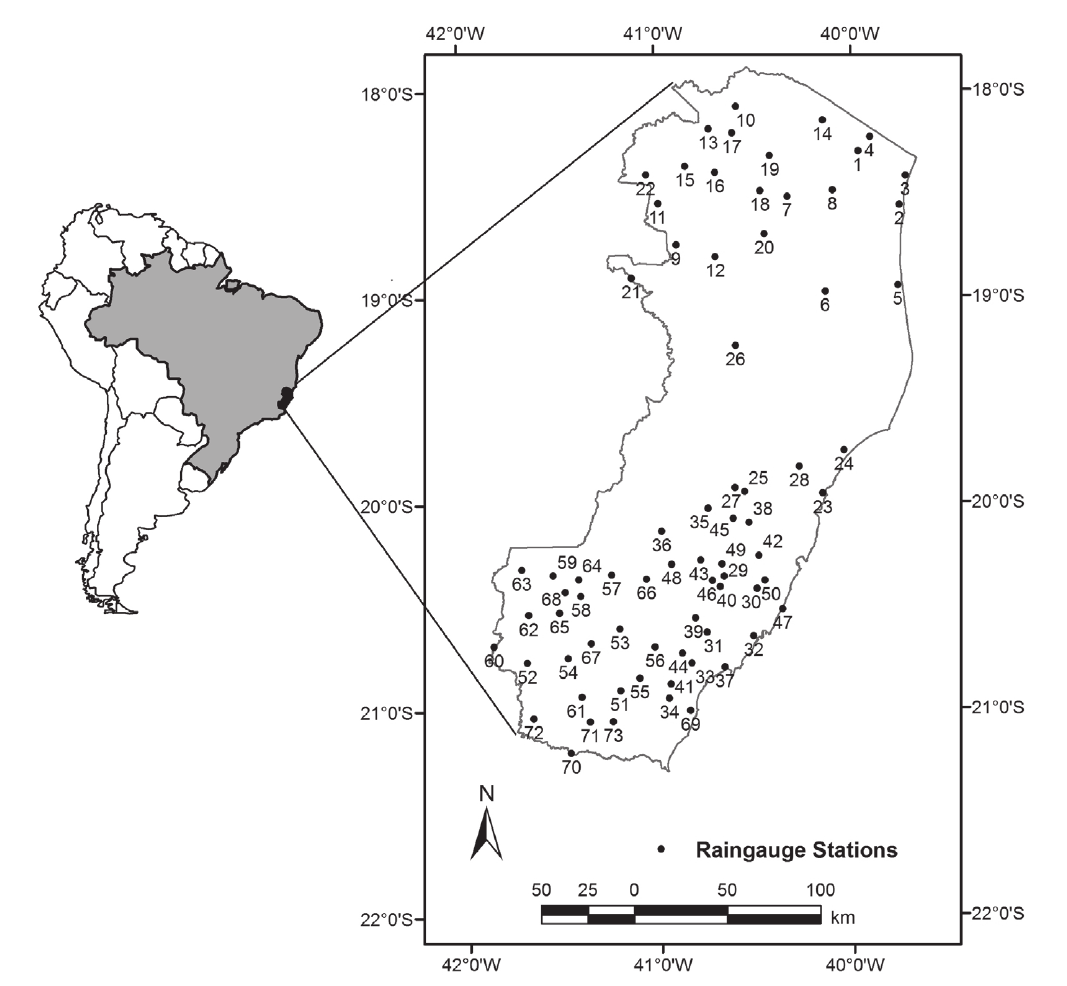
Figure 1 - Pluviometric stations in Espírito Santo State where synthetic rainfall series were